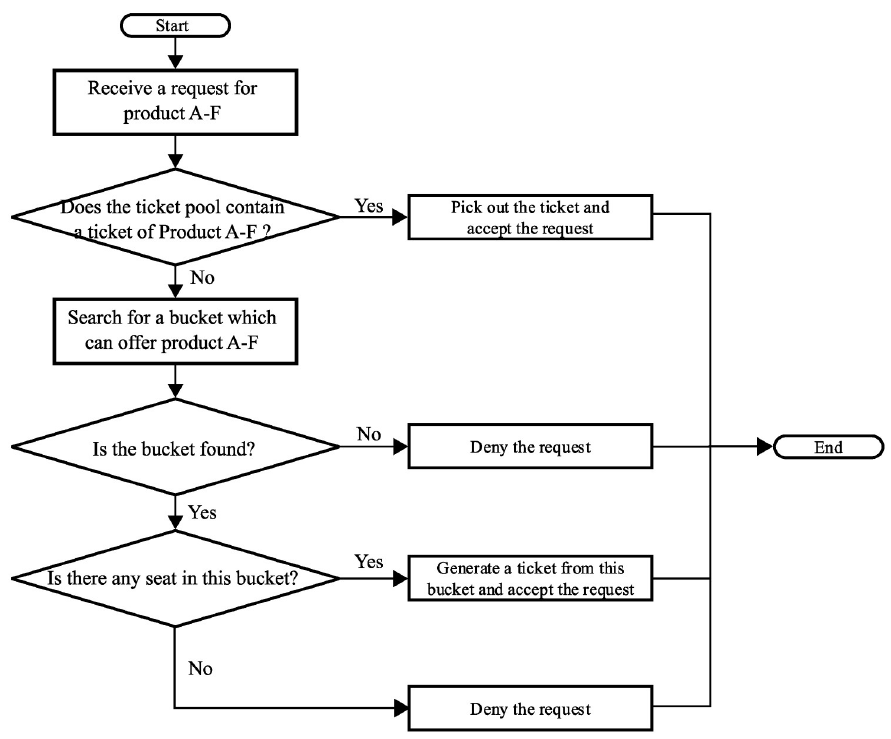
Fig 7. The process of handling a reservation request.